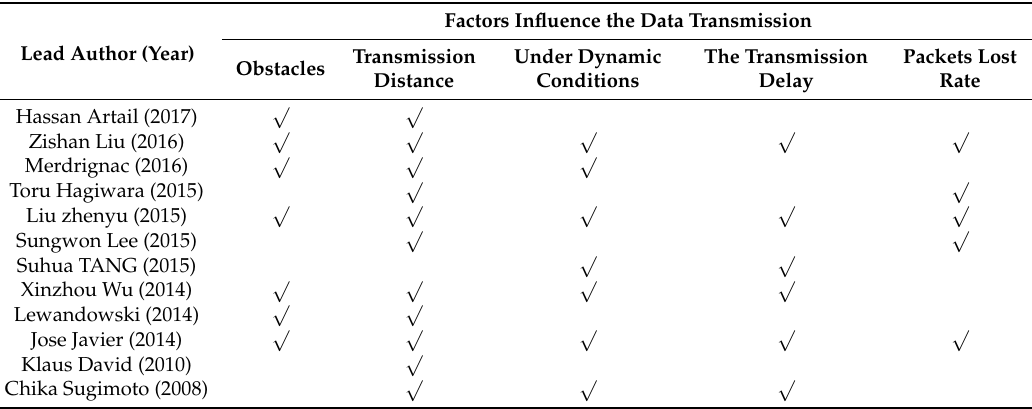
Table 3. Factors influence the data transmission in the selected